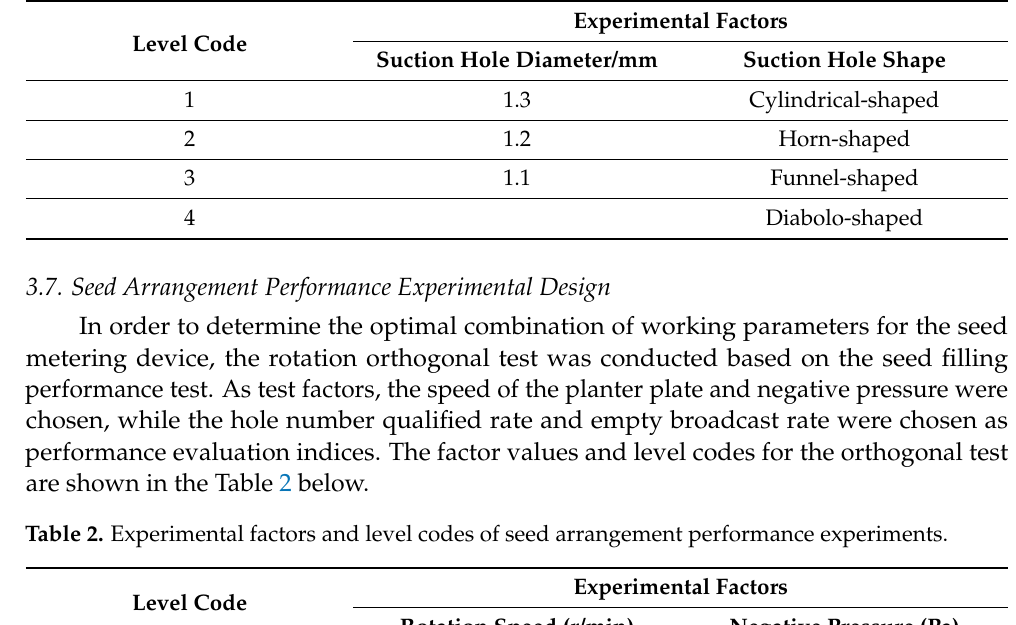
Table 2. Experimental factors and level codes of seed arrangement performance experiments.